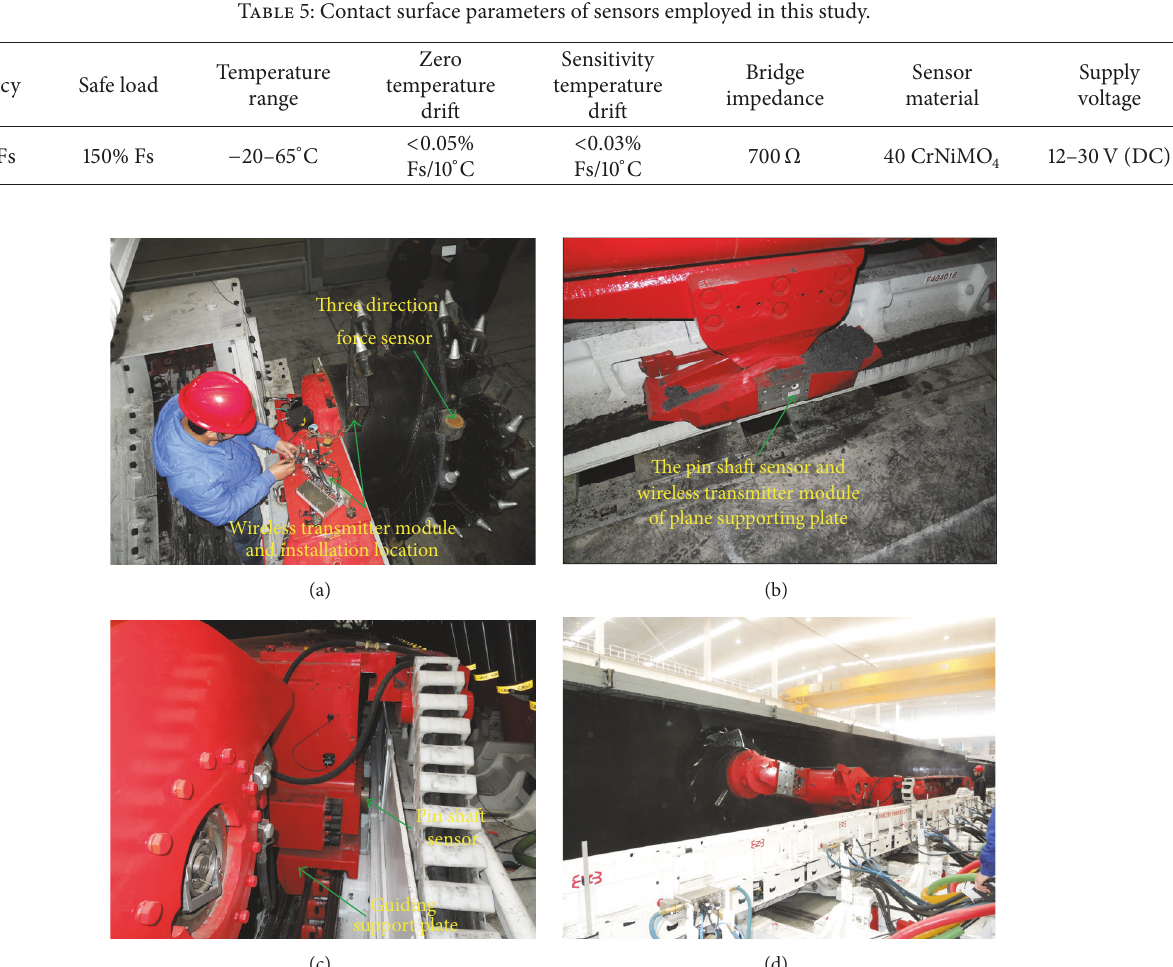
Figure 5: Sensor installation and experimental setup. (a) Test system of shearer pick, (b) plane support plate pin shaft, (c) guiding support plate pin shaft, and (d) experimental